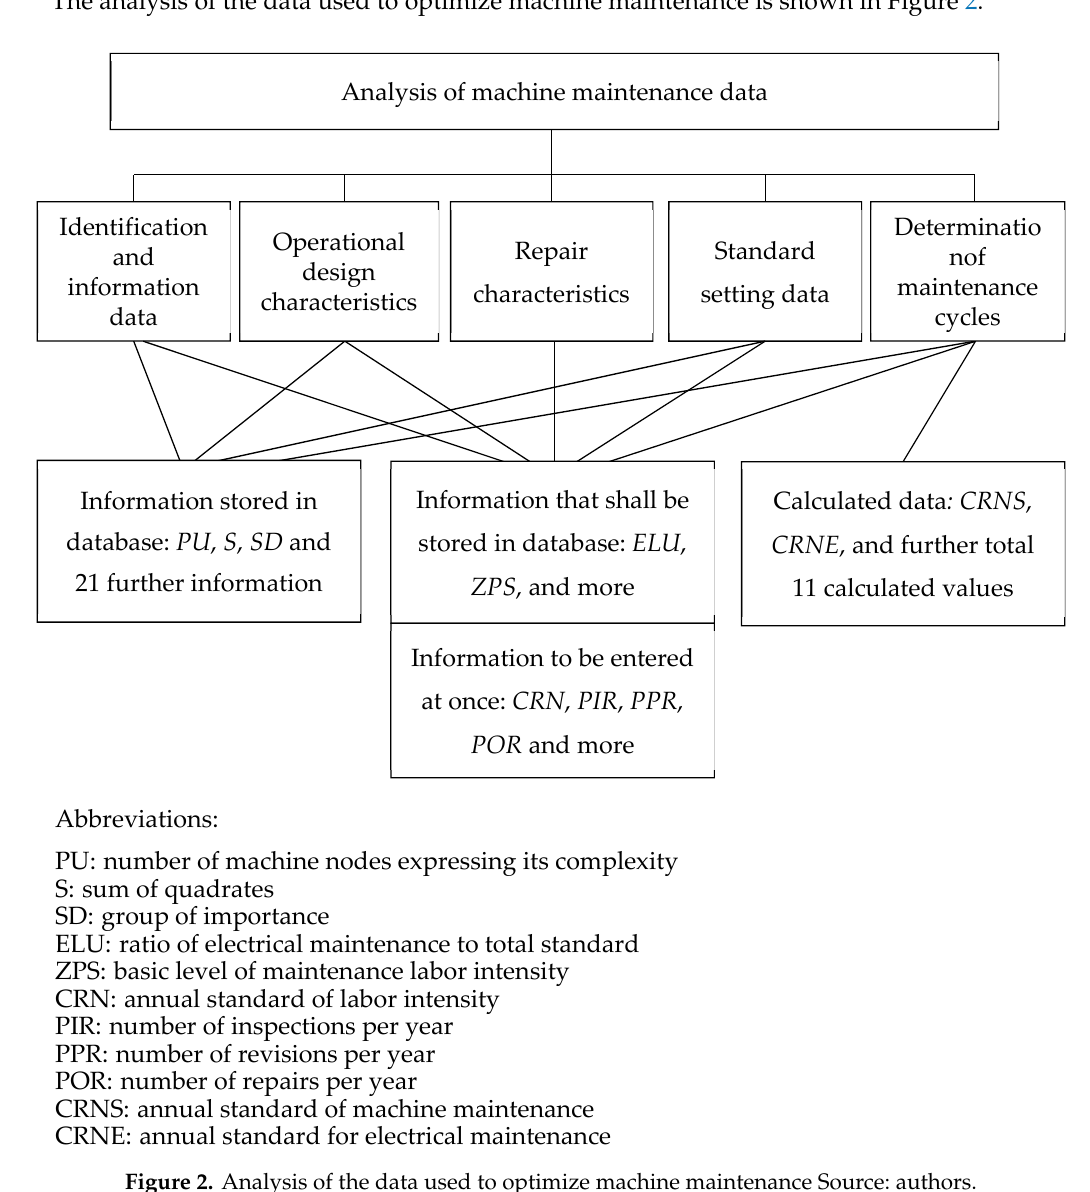
Figure 2. Analysis of the data used to optimize machine maintenance Source: authors.